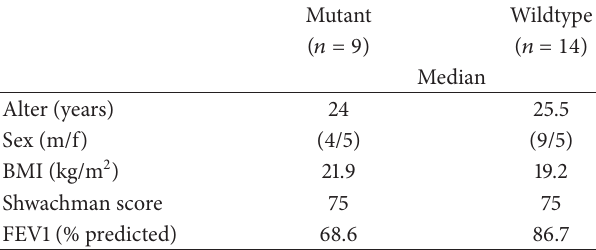
Table 5: TGF 𝛽 1 variant +869T- > C. Patients characteristics.